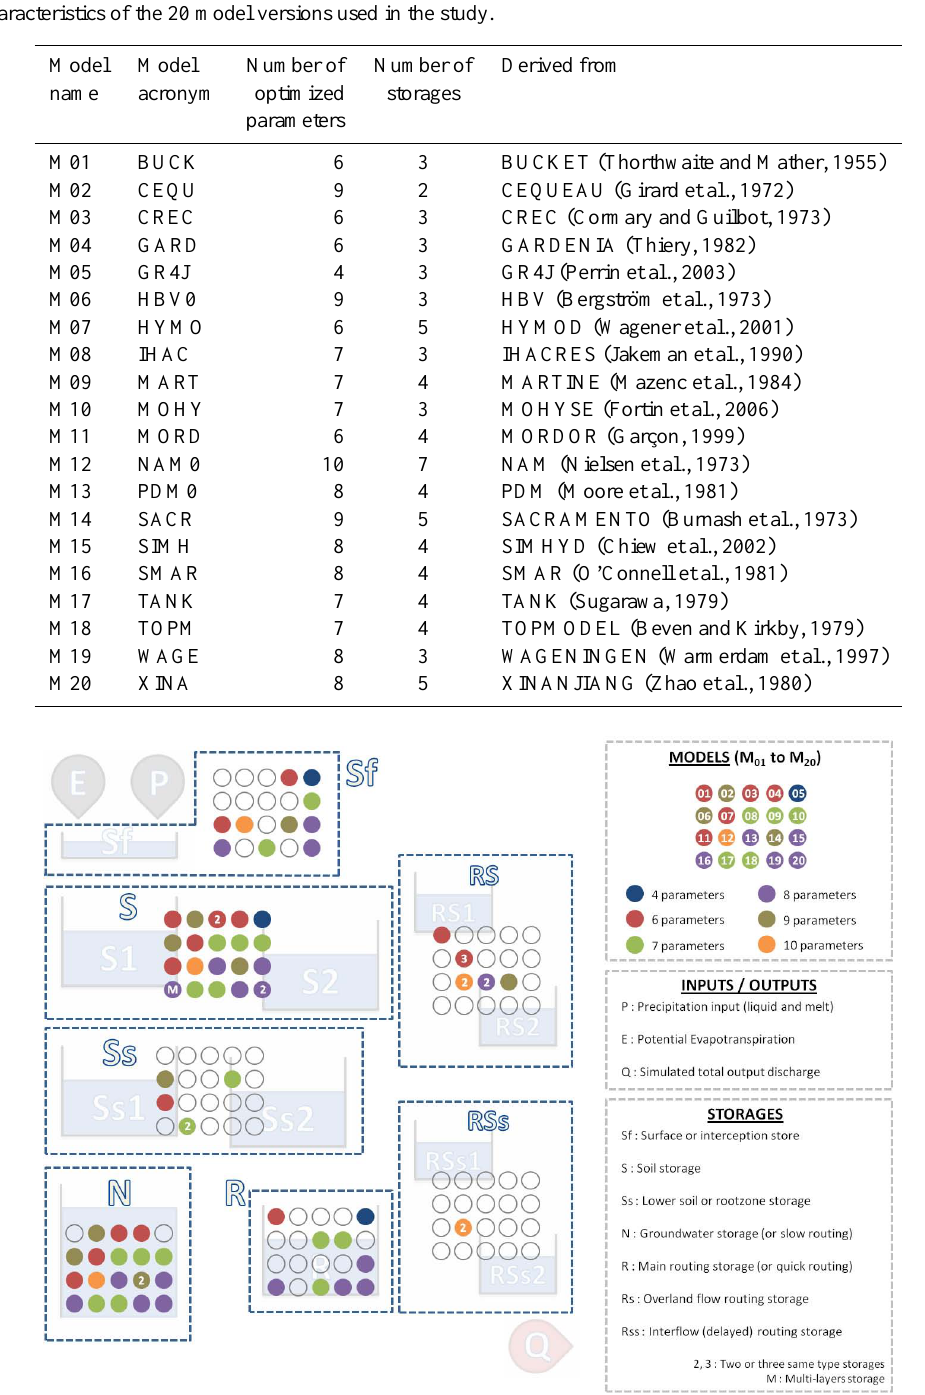
Fig. 3. Illustration of model structural diversity (all models are put in the same